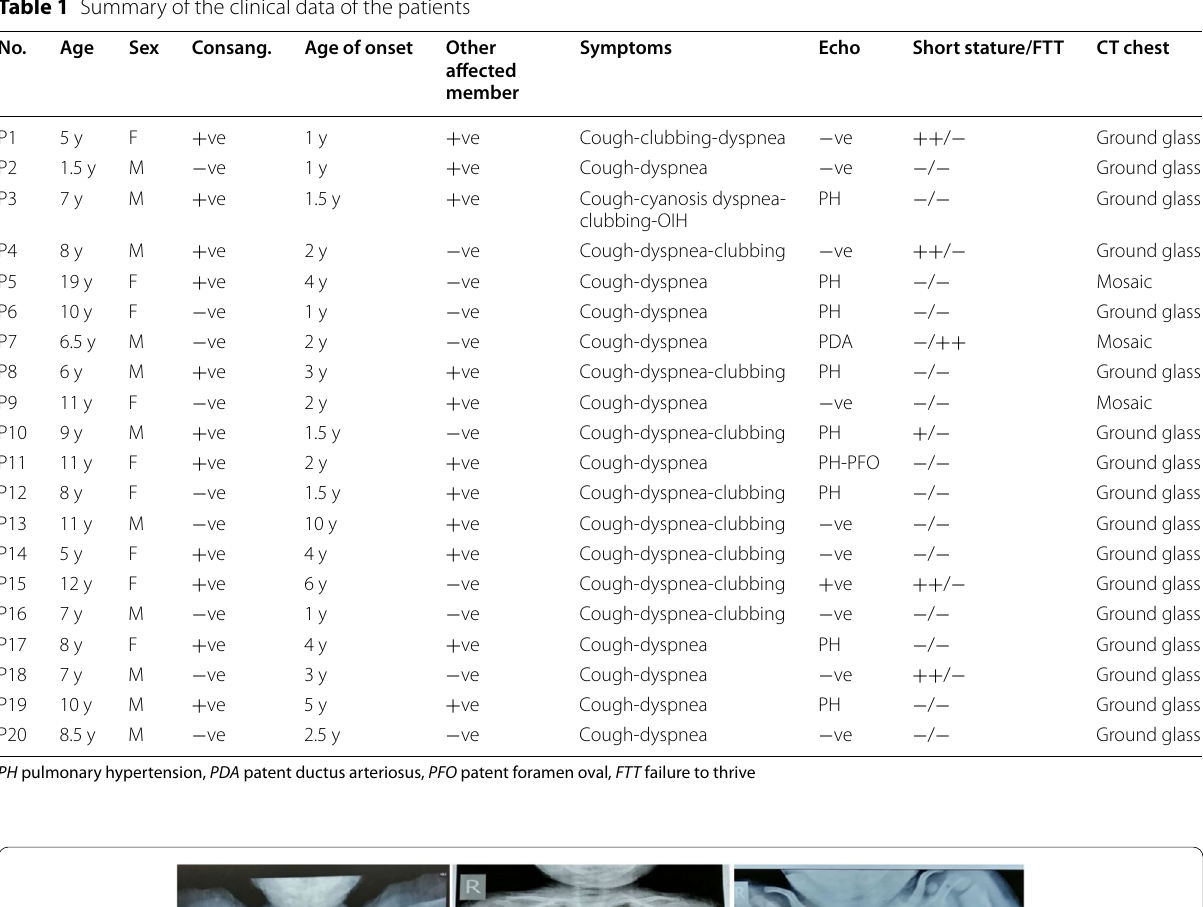
Table 1 Summary of the clinical data of the patients No. Consang.